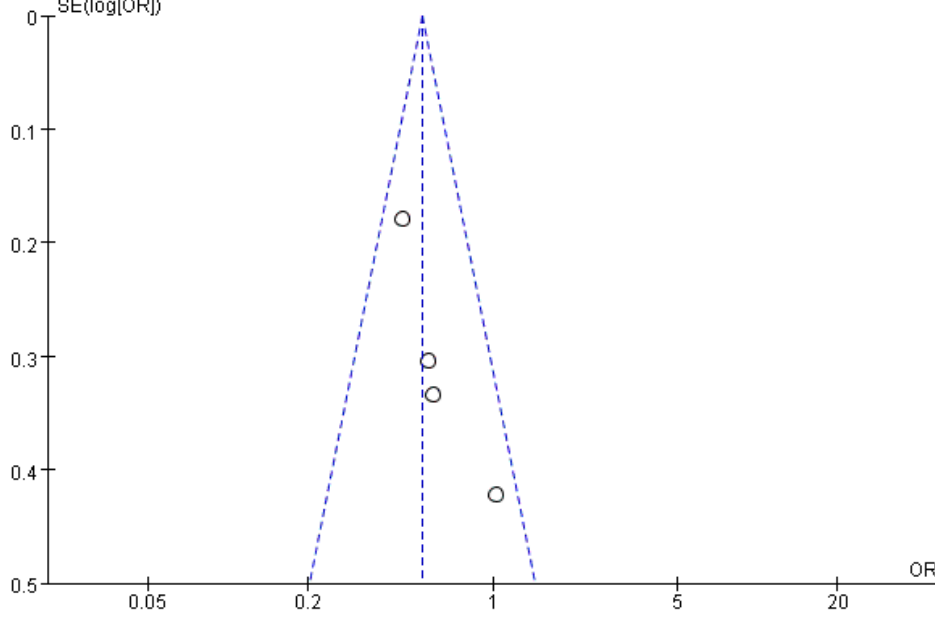
Figure 12. The funnel plot of publication bias for age 6–9 years for flatfoot in children.